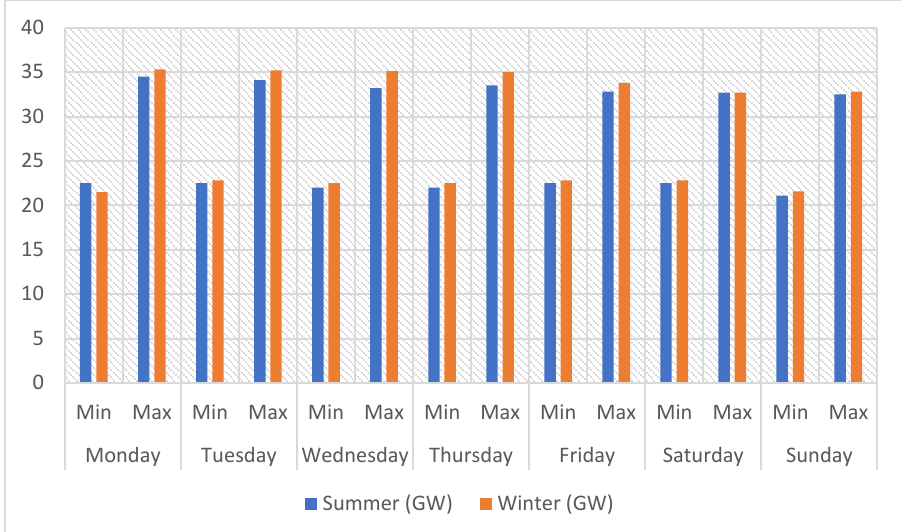
Figure 1. Impact of the load demand during the winter season.